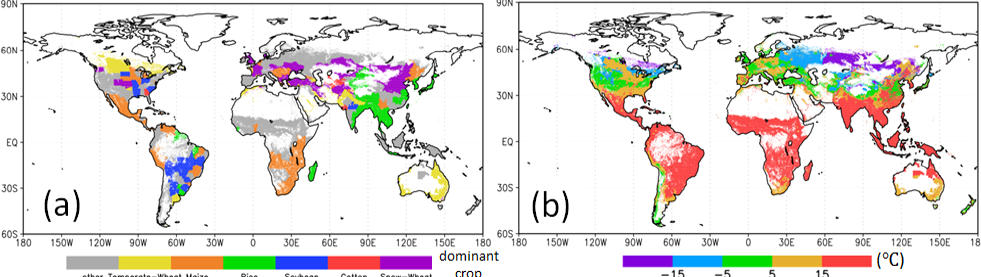
Figure 2. Global distribution of (a) dominant crops in SACRA, and (b) minimum monthly averaged temperature ( ◦ C) during the cultivation period of the dominant crops. Both panels represent the dominant crop in the major cultivation